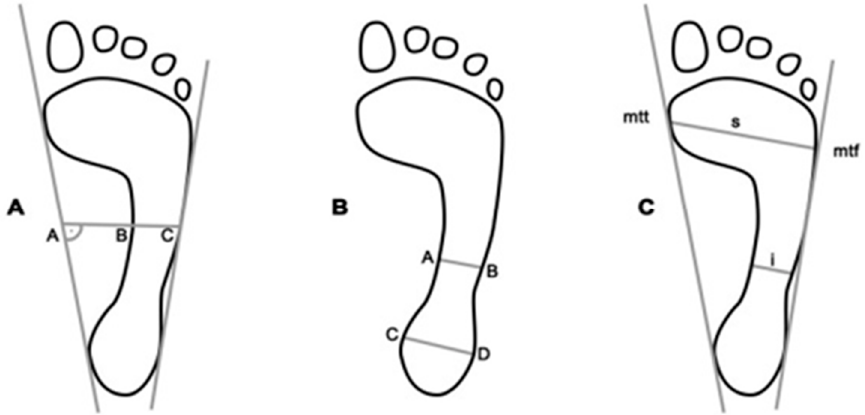
Figure 1. The manner of determining respective indicators. Source: own research material. ( A ) Sztriter-Godunow index (KY); ( B ) Staheli index (SI); ( C ) Chippaux-Smiraka index (CSI).